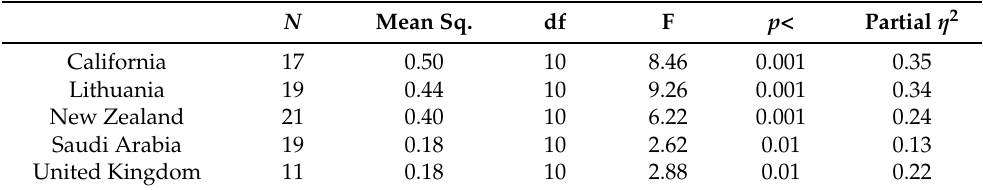
Table 2. Results of the repeated measures ANOVA test (assessing the differences in LMF-HRV- correlation) performed separately for each of the groups at each location. Note that this table shows significant differences in the mean LMF-HRV-correlation between days for each group. N Mean Sq. df F p < Partial η 2